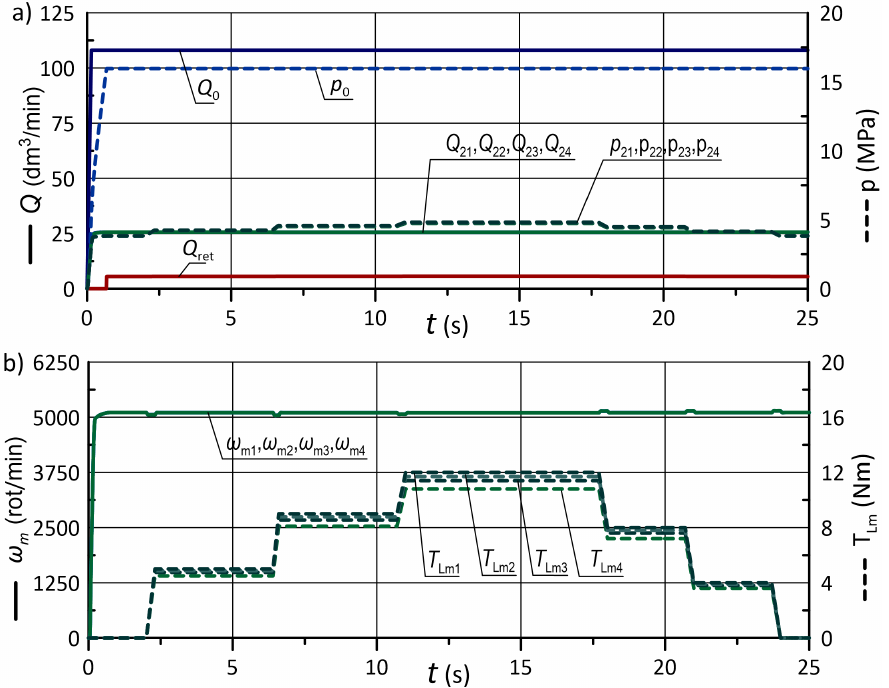
Figure 14. Operating cycle in a low load range, T Lm , max = 12 N m, with load variation of particular motors by 10%; ( a ) flow rates and pressures; ( b ) rotational speed of hydraulic motors and load torques.